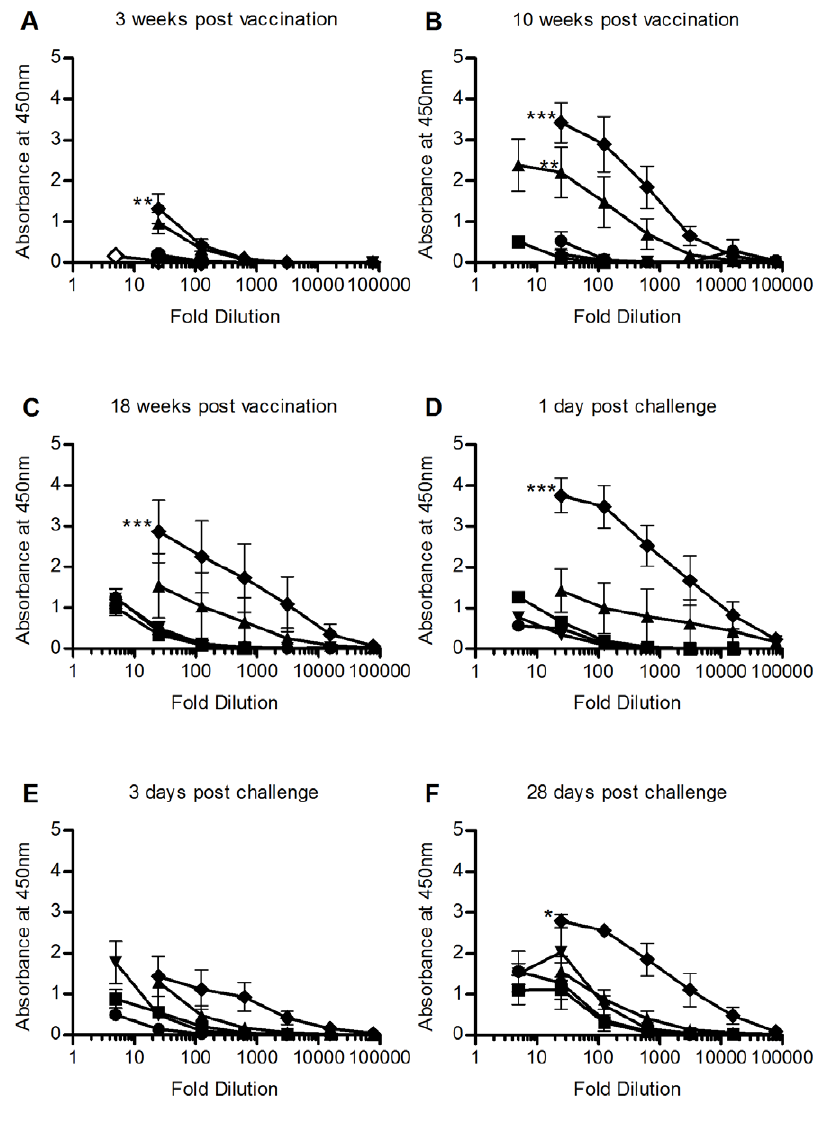
Figure 2. Specific antibody response. Figures 2A–F show the results of the ELISA performed on sera collected from each experimental group at each of the 7 sampling time points. Emptydiamond: Pre vaccination Filledsquare: control, filleddiamond: experimental vaccine, Filledcircle: Freunds incomplete adjuvant, Filledupwardfacingtriangle: AlphaJect 3000, Filleddownwardfacingtriangle: PHARMAQ adjuvant . ANOVA analysis of ELISA results were performed on the measured absorbance of the separate 1:25 dilutions in each group. Asterisks indicate statistically significant difference between treated group and infected controls (*=P , 0.05, **=P , 0.01, ***=P , 0.001). All data shown are mean absorbance 6 SEM.